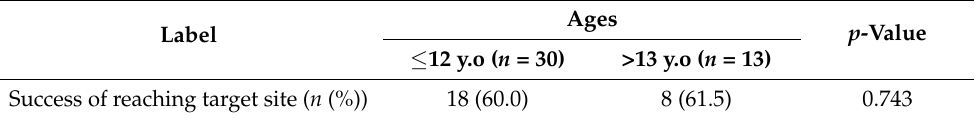
Table 4. Success of reaching target site of BEA-ERC 1 for pediatric patients with biliary atresia after LDLT.